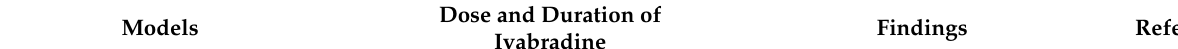
Table 4. Effects of ivabradine on the cardiac conduction system and renin–angiotensin–aldosterone